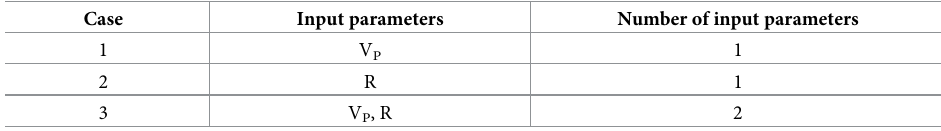
Table 10. BPNN structure based on different input parameters.